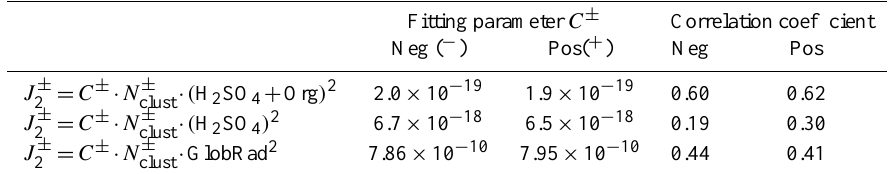
Table 1. Values of the fitting coefficients C and correlation coefficients for the parameterizations of Eqs. (3) and (5). When using the parameterizations, the cluster ion and vapor concentrations are given in units of moleculescm − 3 , and global radiation in Wm − 2